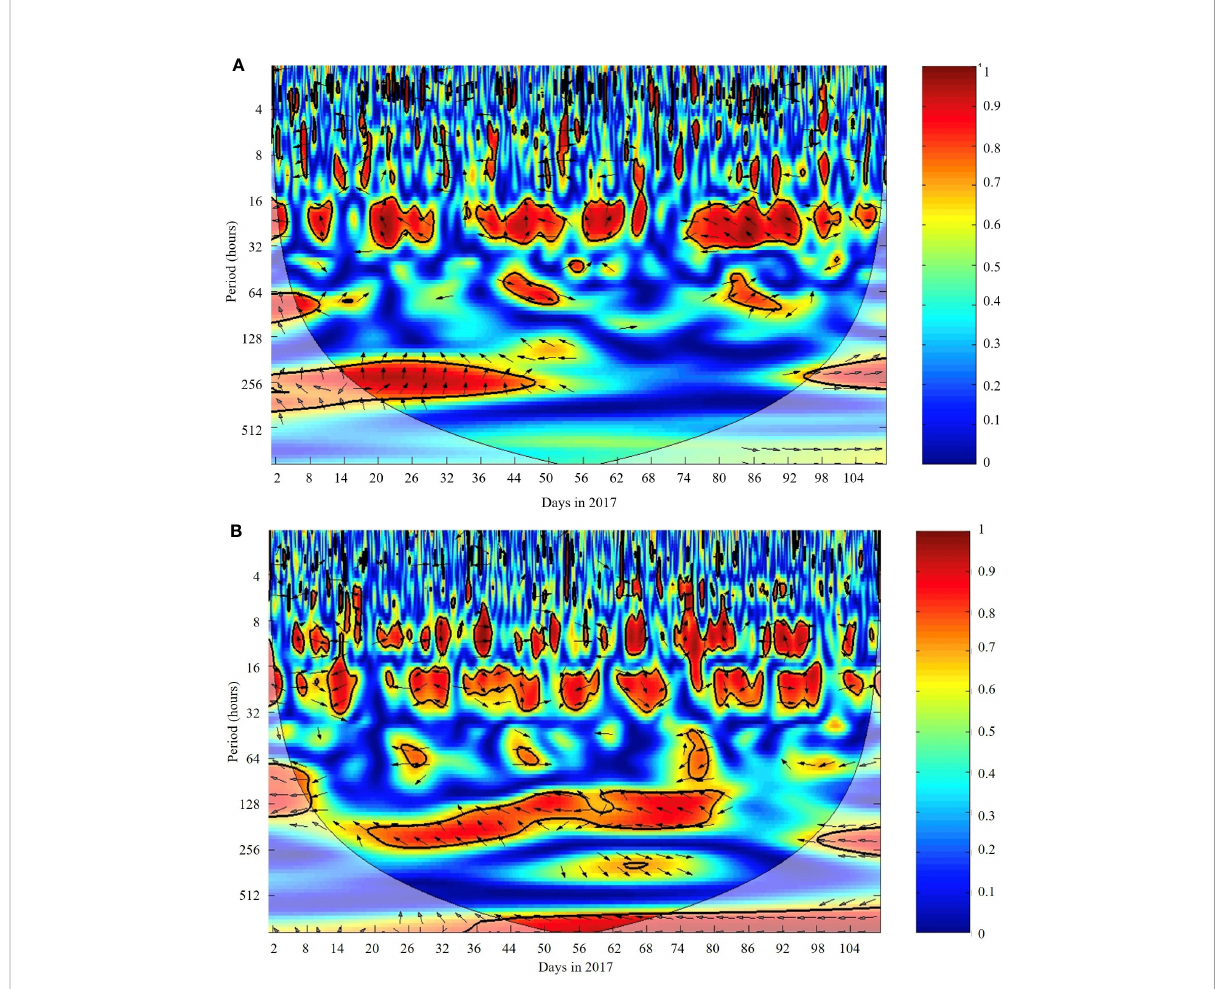
FIGURE 7 Cross-wavelet coherence of CO 2 fl uxes and windspeed (A) and CO 2 fl uxes and water pressure anomaly (B) for the period spanning from January up to April 2017. The contours are for variance units. The 5% signi fi cance level against red noise is shown as a thick contour (cone of in fl uence). Blurred regions indicate values outside the cone of in fl uence. The vectors indicate the relative phase between the variables. The horizontal scale represents the Julian days in January-April 2017